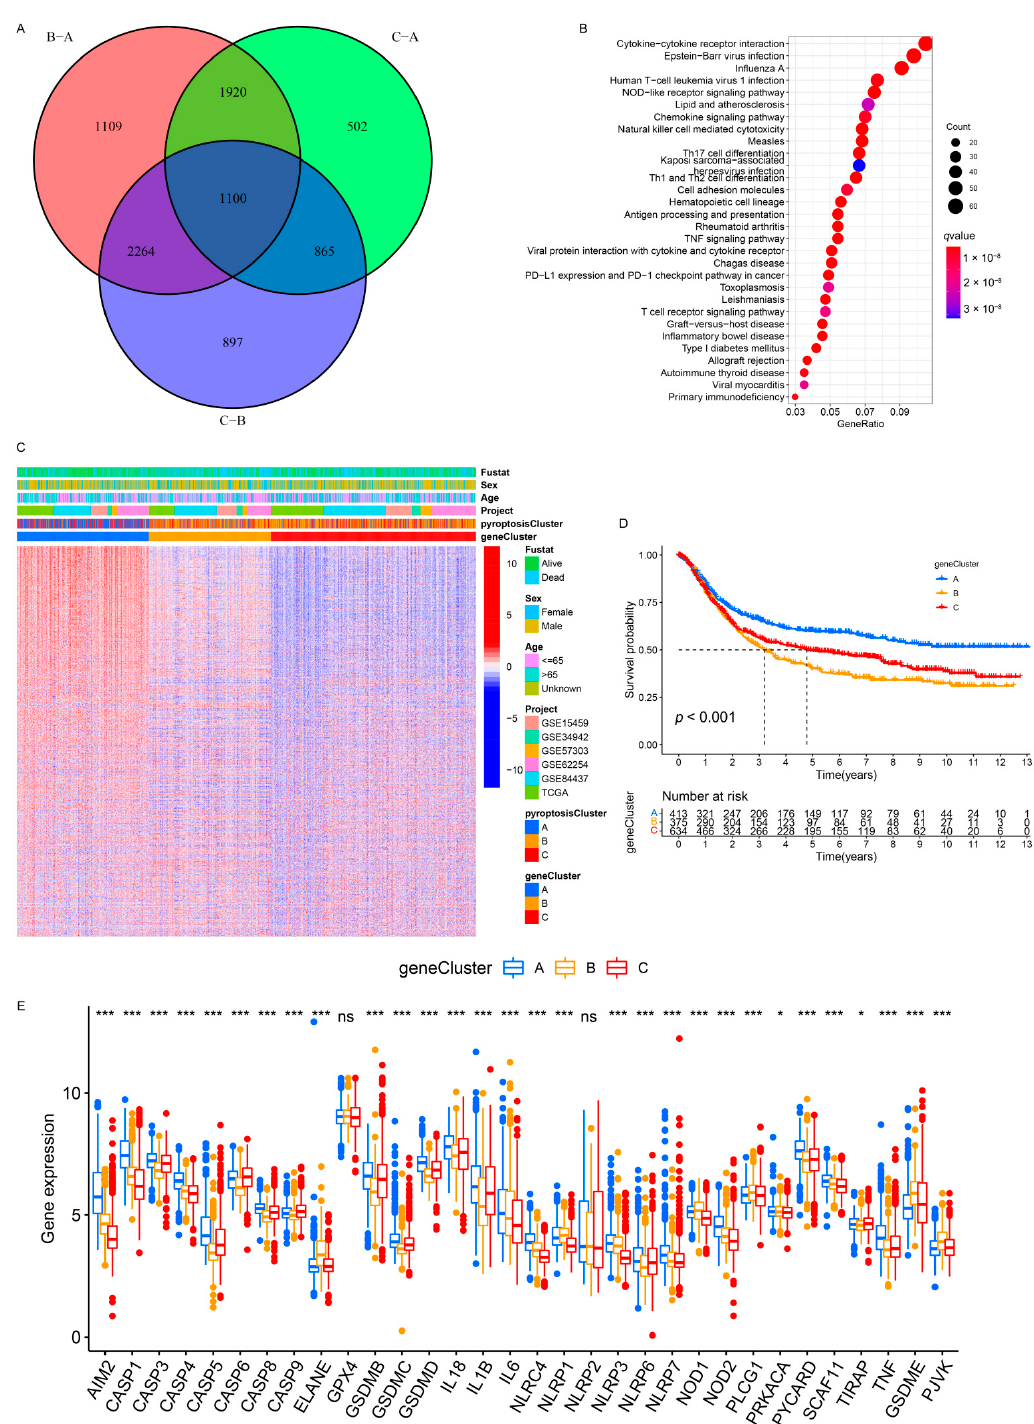
Figure 5. Unsupervised clustering of pyroptosis pattern-related genes in the meta-cohort. ( A ) One thousand and one hundred pyroptosis pattern-related genes were shown in the Venn diagram. ( B ) KEGG enrichment analysis for pyroptosis pattern-related genes. The x-axis represented the gene ratio. ( C ) Unsupervised clustering of overlapping pyroptosis pattern- related genes in the meta-cohort divided the patients into three distinct clusters, called gene clusters A–C, respectively. ( D ) Kaplan–Meier analysis for three distinct gene clusters with 1422 GC patients in the meta-cohort (Log-rank test: p < 0.001). ( E ) The expression of the PRs in the three gene clusters in the meta-cohort. The upper and lower ends of the boxes represented an interquartile range of the values. The lines in the boxes represented the median value (one-way ANOVA test: * p < 0.05; *** p <